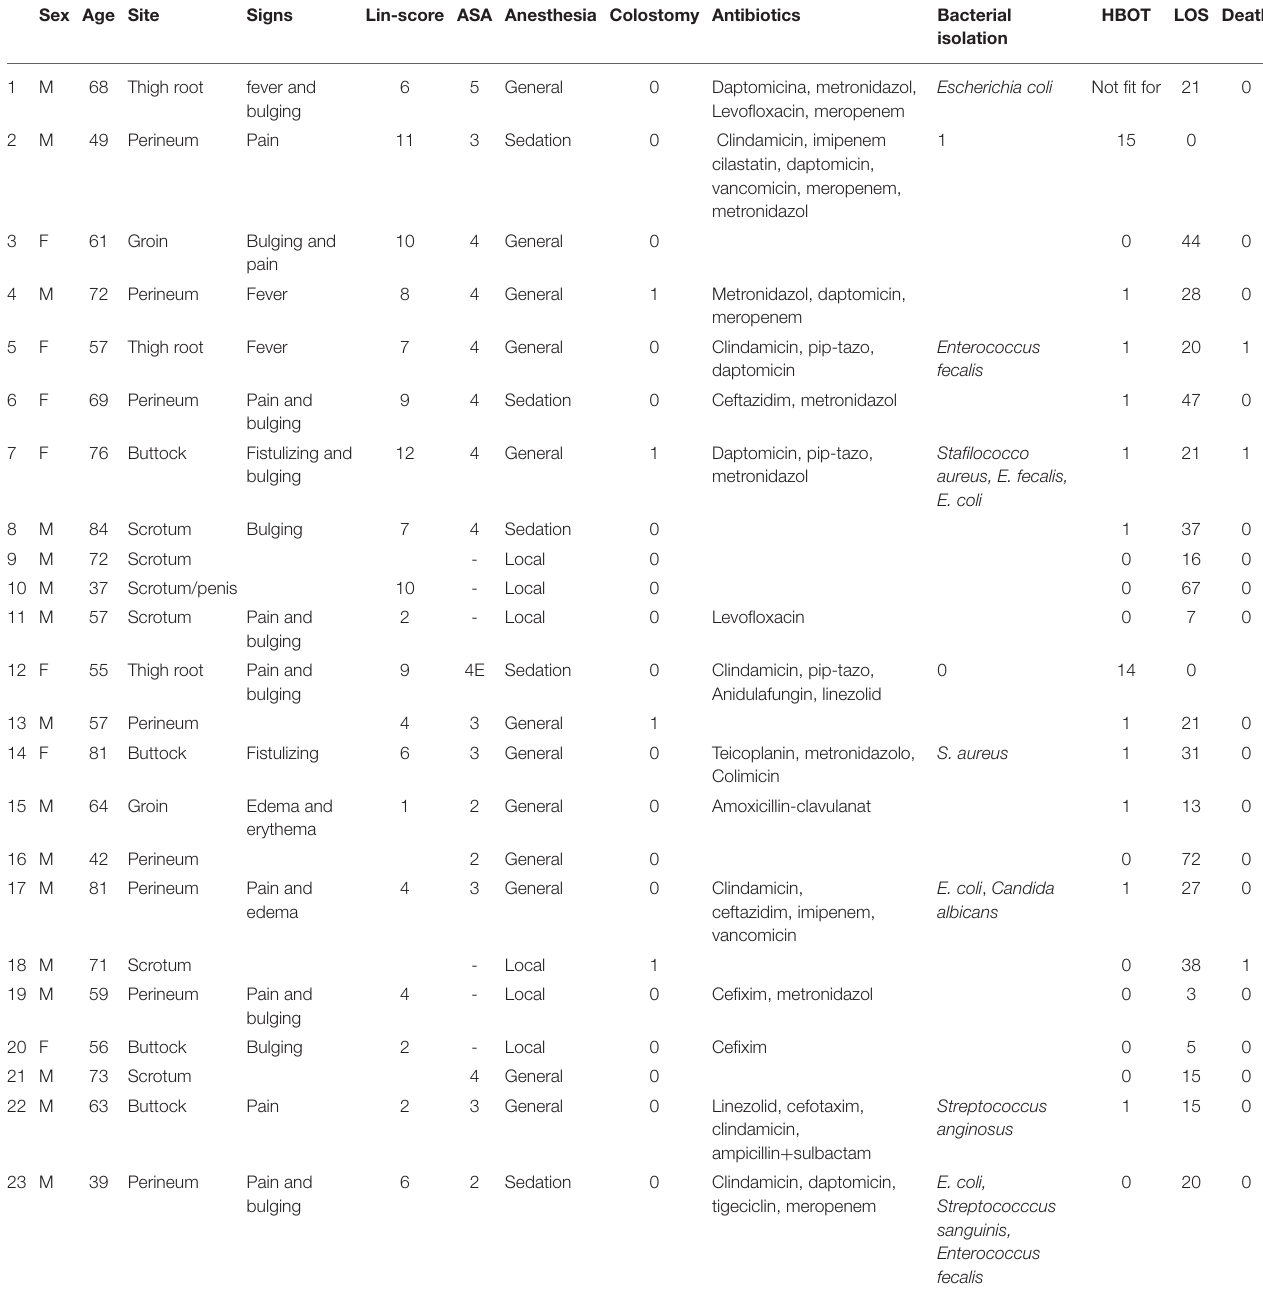
TABLE 4 | Patient